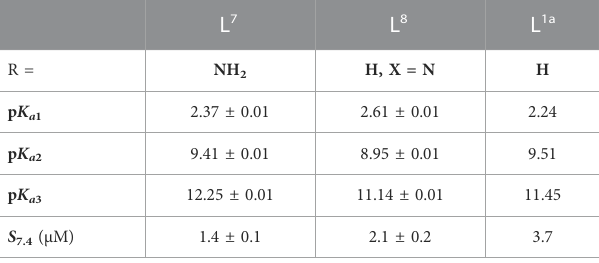
TABLE 2 p K a values of the studied ligand precursors determined by UV-Vis spectrophotometric titrations in 30% (v/v) DMSO/H 2 O in addition to their thermodynamic solubility ( S 7.4 ). [t = 25.0 ° C; I = 0.1 M (KCl)].